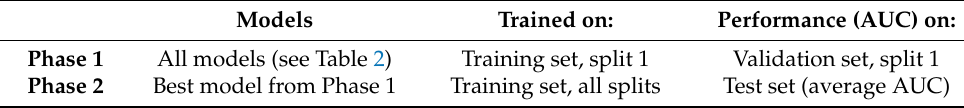
Table 3. Training and evaluation